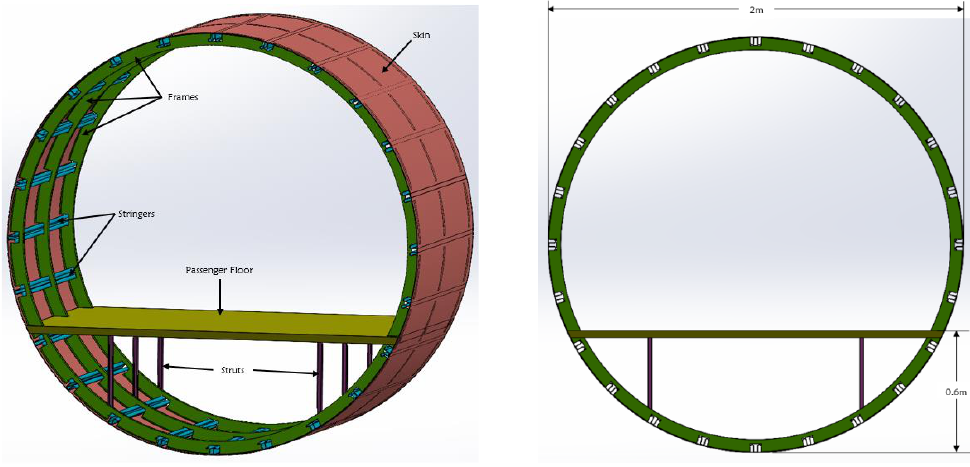
Figure 1a: Fuselage components Figure 1b: Fuselage dimension Figure 1: Fuselage components with dimension